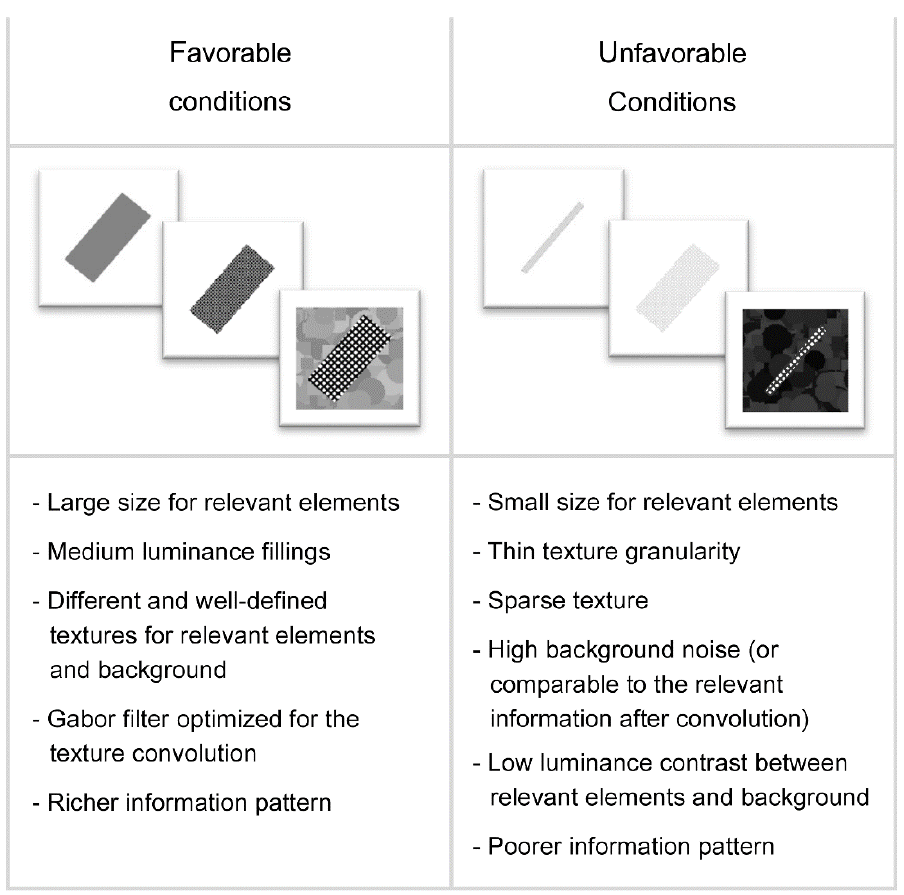
Figure 14. Summary of results. The table summarizes the most favorable and the less favorable conditions, for a classification task performed with HMAX.